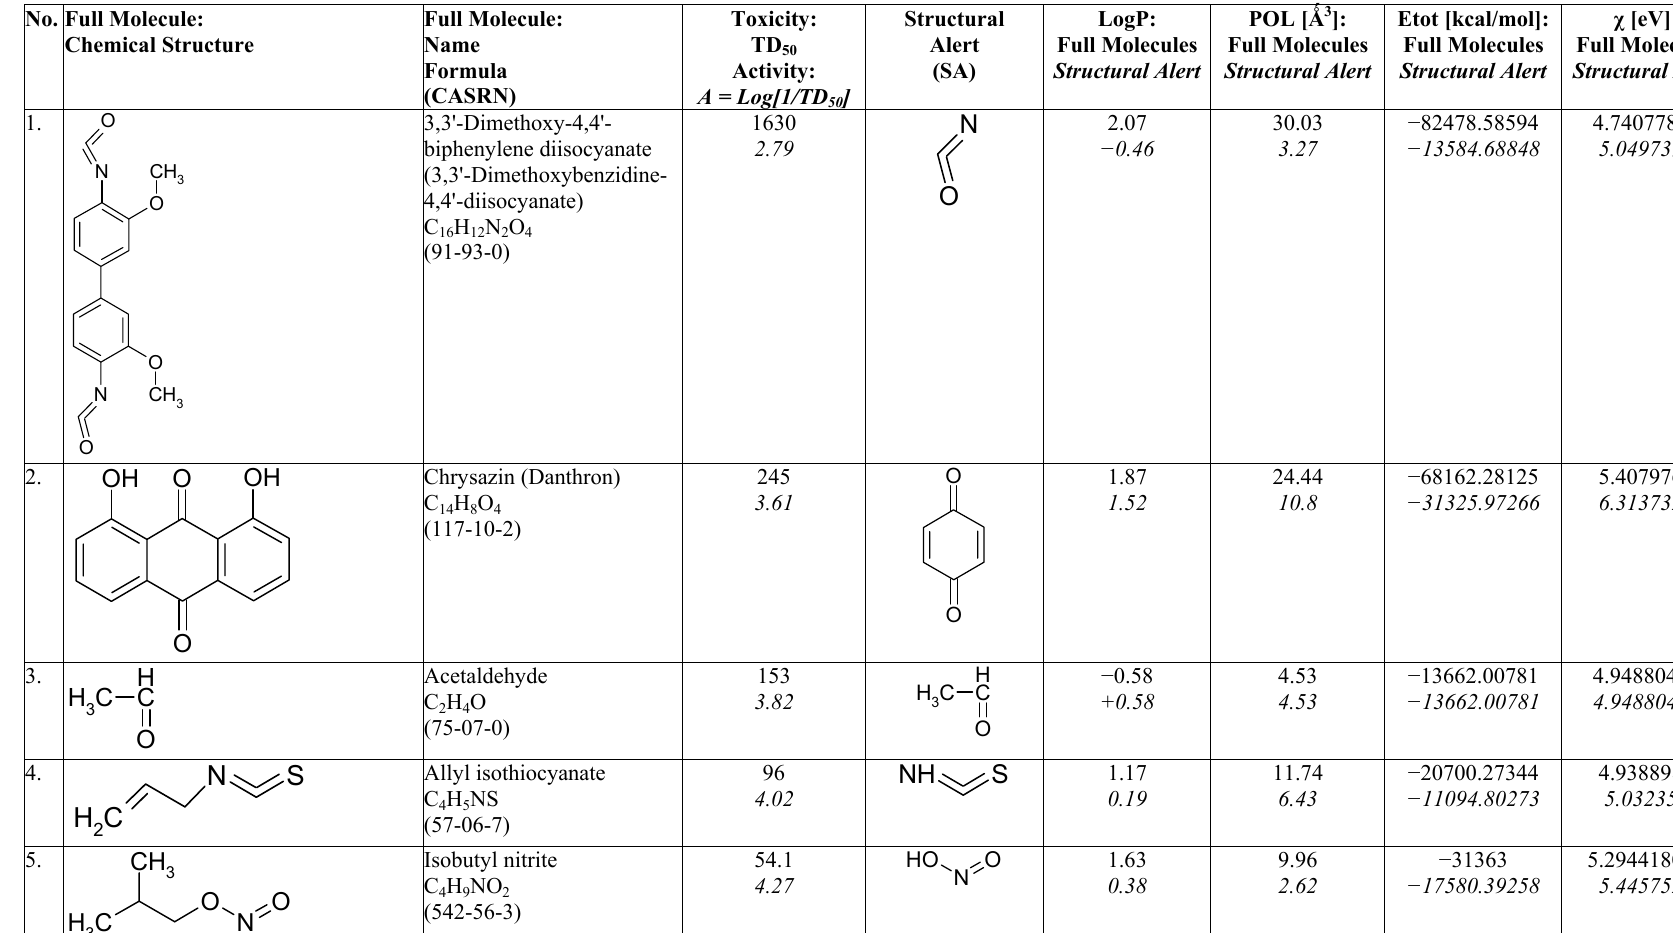
Table 1. Molecules from the Gaussian training set (Figure 2) and corresponding rat TD activities A = Log(1/TD ) using semi-empirical PM3-computed (Hyperchem [30]) structural parameters: hydrophobicity (LogP), 50 polarizability (POL) [ Ǻ 3 ], total optimized energy (Etot) [kcal/mol], electronegativity ( χ = − 0.5( ε ( η = 0.5( ε – ε )) LUMO HOMO